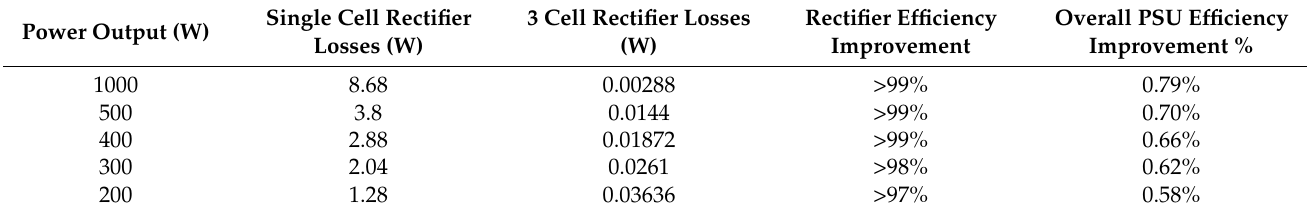
Table 3. Comparison of 1-cell and 3-cell rectifier system.